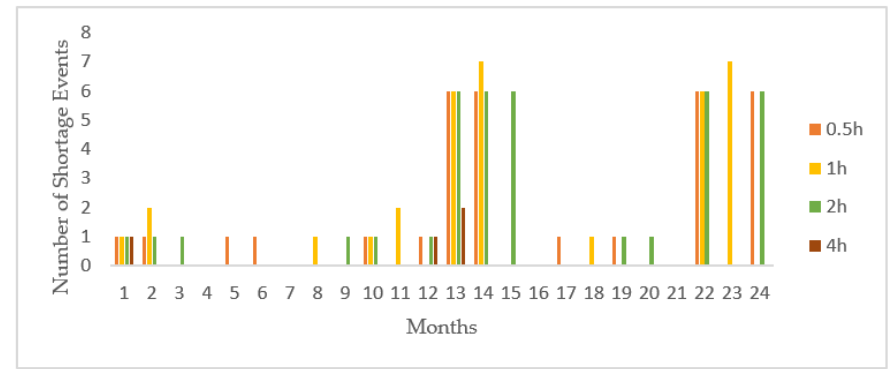
Figure 4. Battery cycling profile according to the number of expected shortage events in the capacity market. capacity